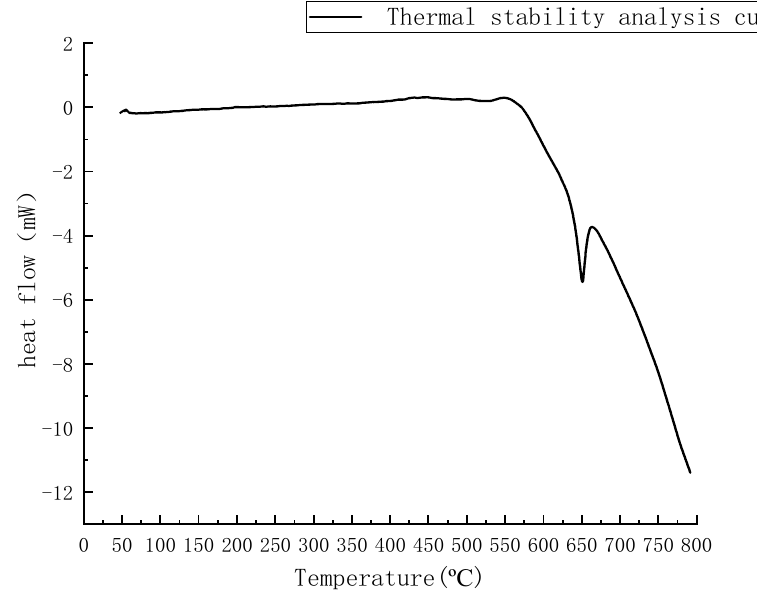
Figure 1. Alloy powder thermal stability analysis curve .